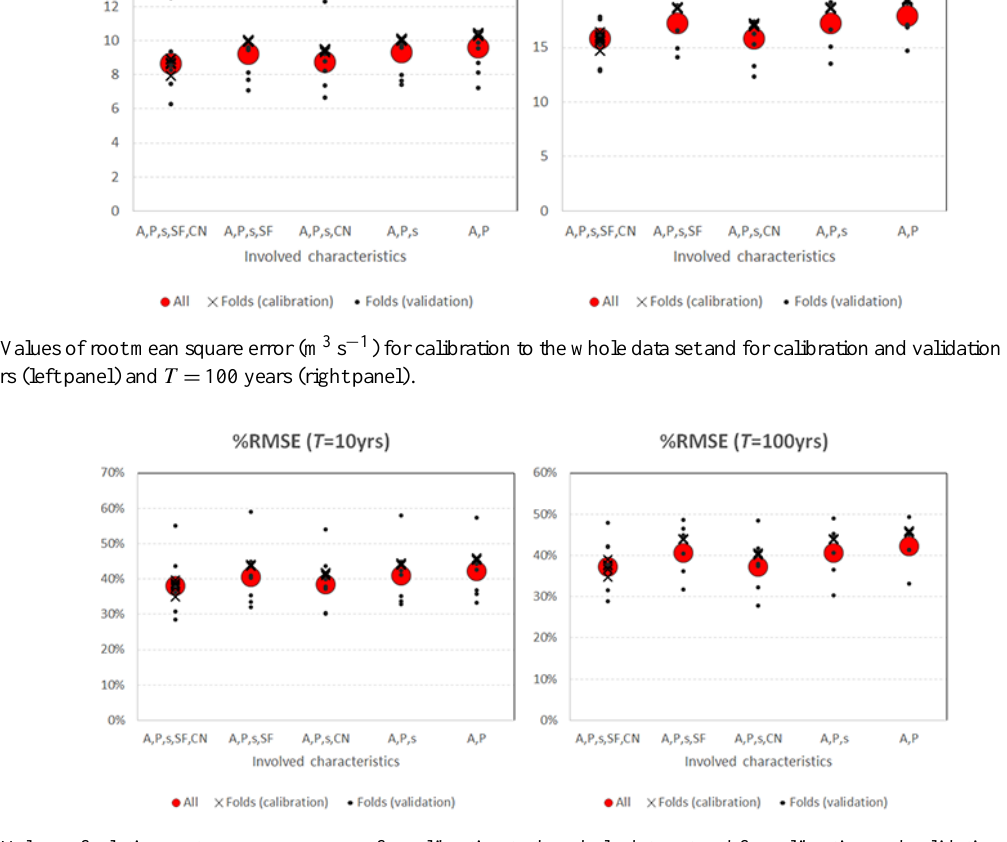
Figure 17. Values of relative root mean square error for calibration to the whole data set and for calibration and validation using 7 folds for T = 10 years (left panel) and T = 100 years (right